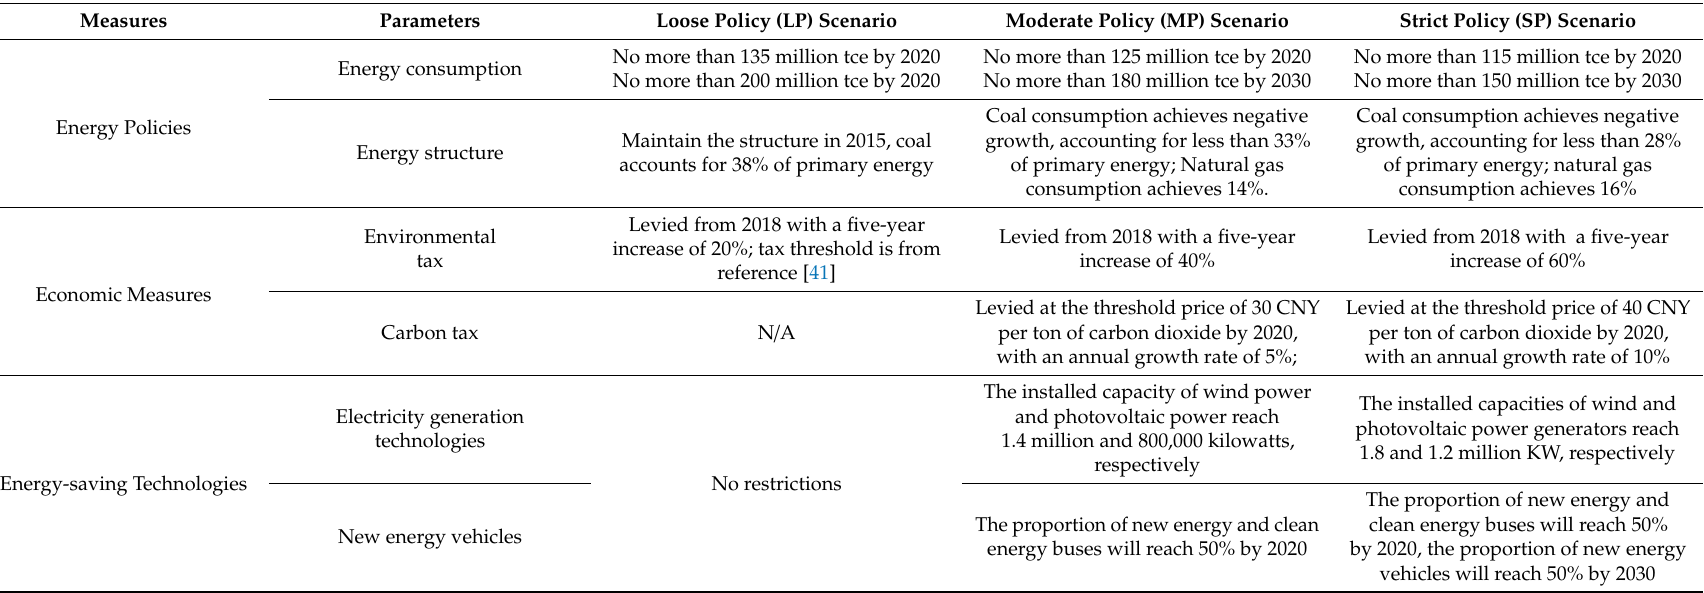
Table 3. The definition of the three policy